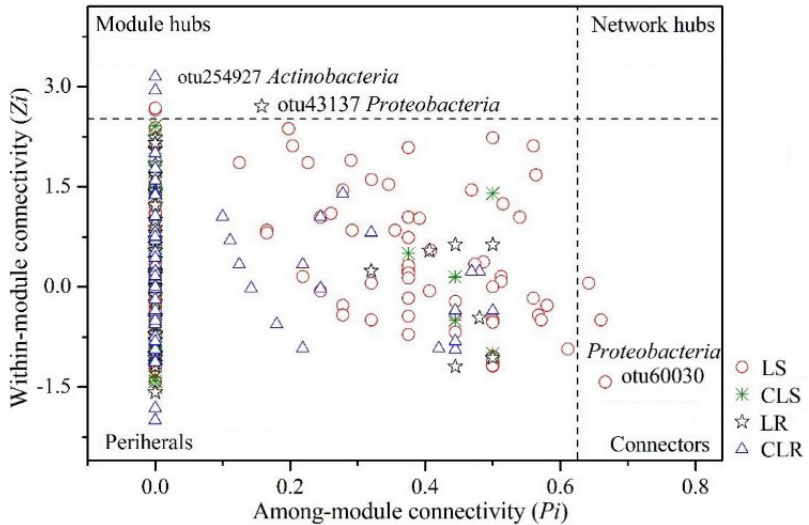
Figure 4. Zi–Pi plot of molecular ecological networks in mining subsidence area and vegetation rehabilitation area. rehabilitation